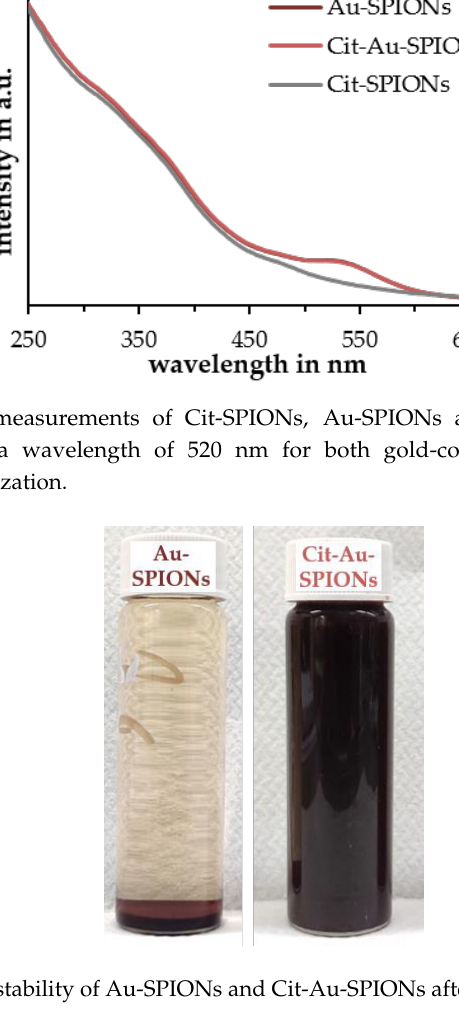
Figure A2. Dispersion stability of Au-SPIONs and Cit-Au-SPIONs after one week of storage at 4 °C.